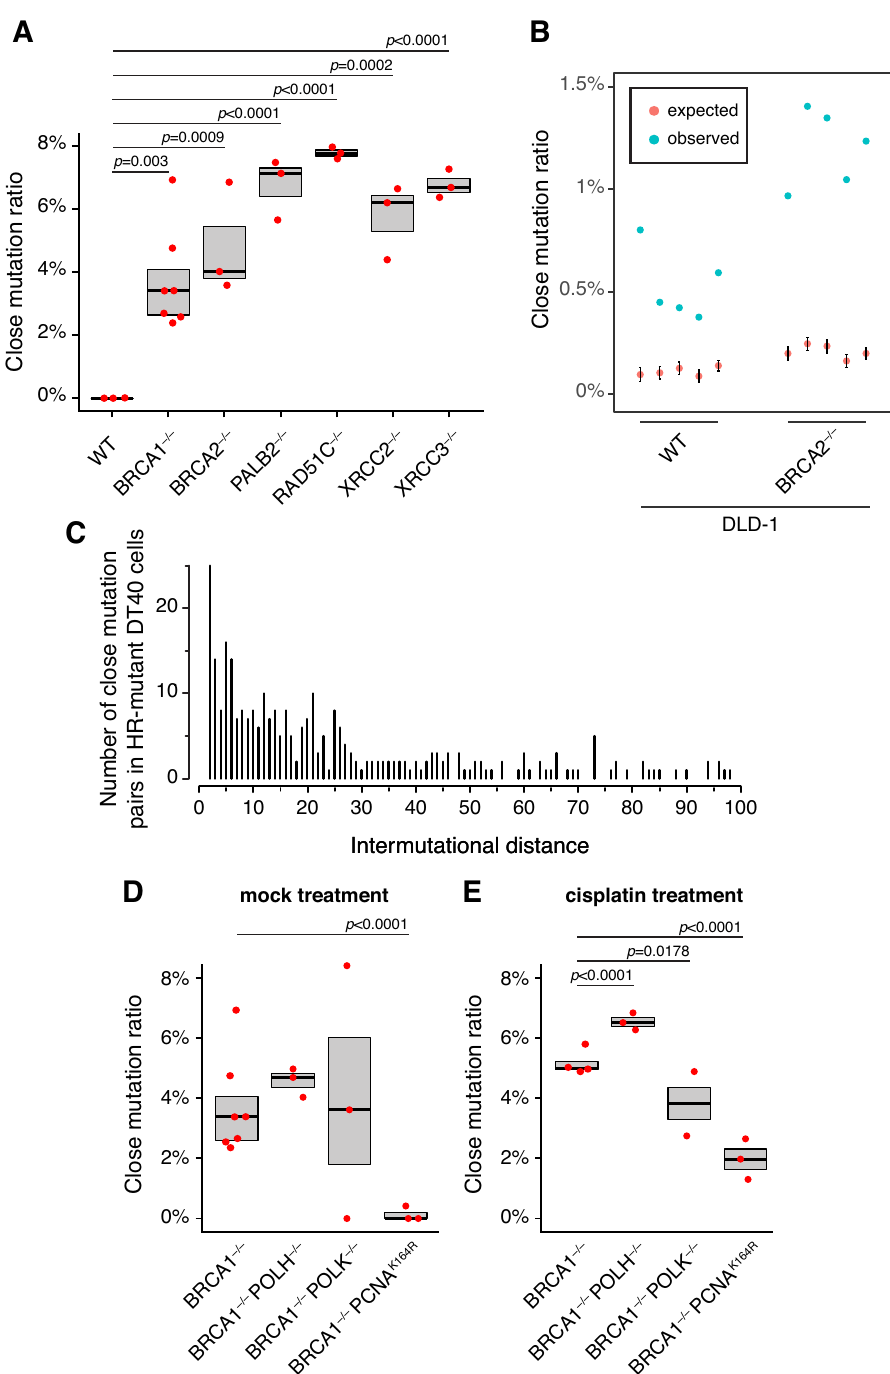
Fig 4. Characterisation of homologous recombination-dependent collateral mutagenesis. (A) Close mutation ratios in HR mutant DT40 cell lines are elevated, compared to the proportion in wild type cells. Red markers refer to values of individual samples, while the boxes indicate means and standard errors. Statistical significances were obtained using two-sample proportion tests. (B) Close mutation ratios in wild type and BRCA2 –/– DLD-1 cells. Blue markers show the observed close mutation ratios for each sample; red markers indicate expected ratios drawn from 1000 random simulations of the same number of substitutions. (C) Intermutation distance distribution of close mutation pairs from all HR mutant DT40 clones. (D) Close mutation ratios in mock treated BRCA1 double mutant